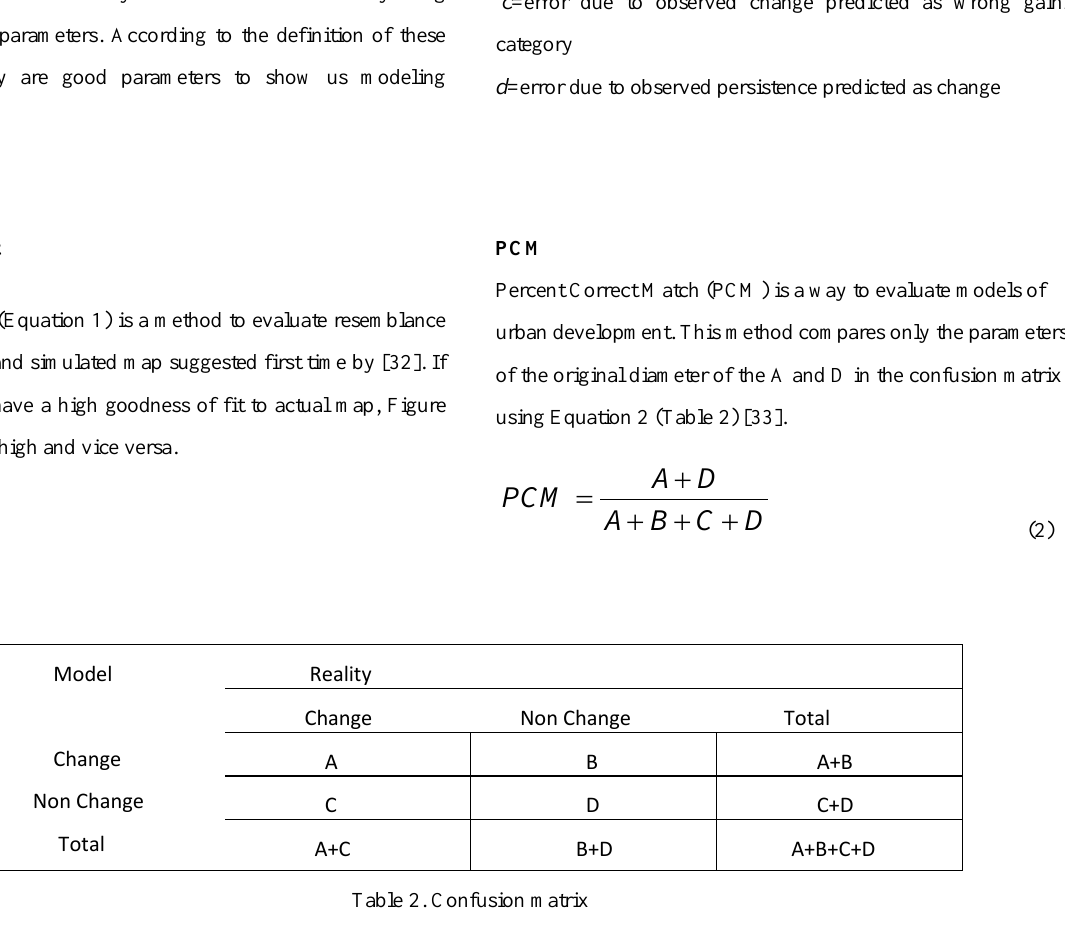
After the model calibration using historical observed data (10%) of the year 2000 and 2006, the model simulated (the rest of the